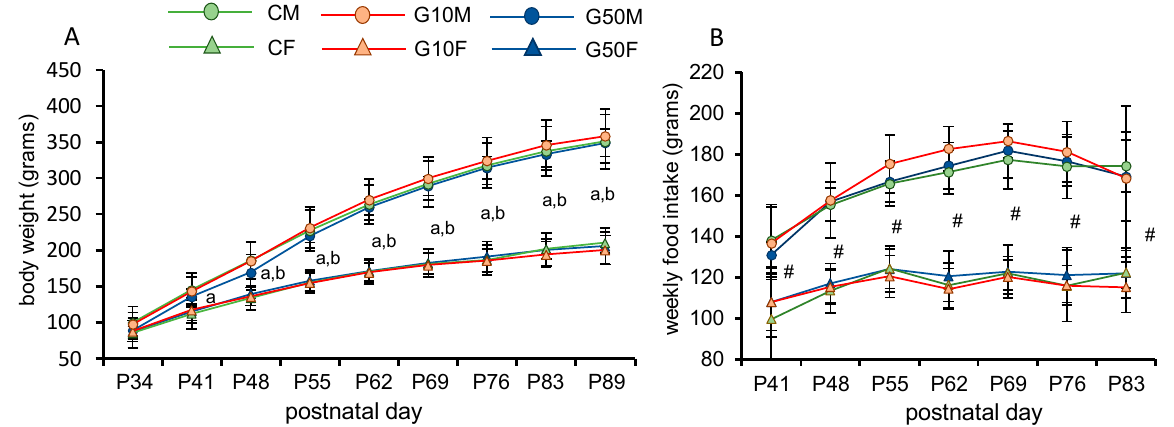
Figure 1. ( A ) Body weight evolution in all groups. ( B ) Weekly food intake in all groups (repeated measured ANOVA). Statistically significant differences ( p < 0.05) are labelled as follows: a = sex differences in C and G10 groups; b = sex differences in G50 groups. # = sex differences in all groups studied. All values are expressed as means ± S.D. CM: control males: CF: control females; G10M: genistein treated males, dose 10 µg/g; G10F: genistein treated females, dose 10 µg/g; G50M: genistein treated males, dose 50 µg/g; G50F: genistein treated females, dose 50 µg/g.